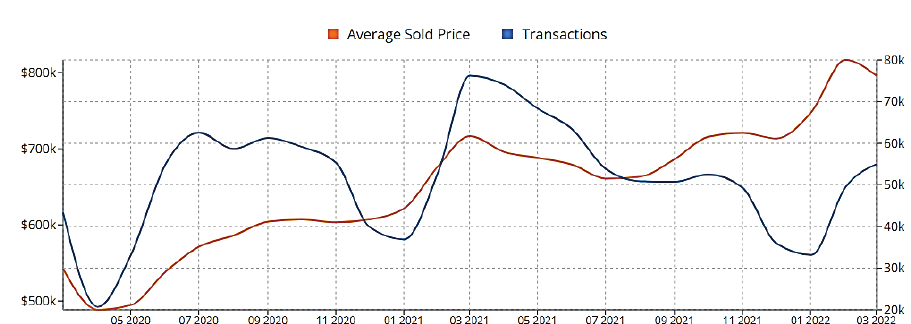
Fig. 1. Trends in the Canadian real estate market housing price (Bayat,